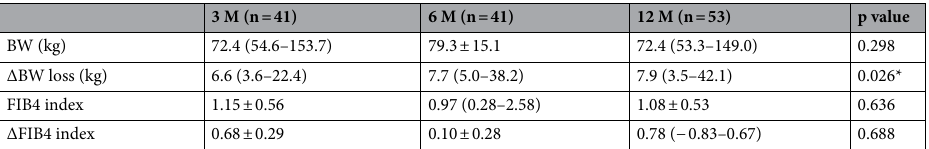
Table 3. Body weight and the FIB4 index of patients who achieved their weight loss goals. Patients successfully reduced their BW by more than 5% from baseline BW after 3, 6, and 12 months (M) of weight reduction therapy. Data are expressed as the mean ± SD or medians (min, max). Asterisks indicate a significant difference (p < 0.05) by the Kruskal–Wallis test.